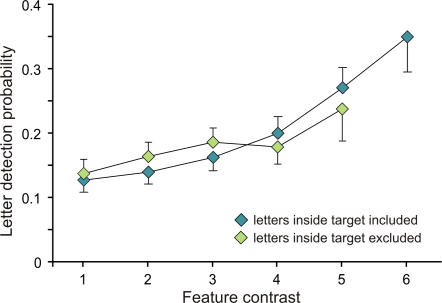
Effect of local orientation contrast on letter detection probability.The letter detection rate increased proportionally with the orientation contrast. Contrast level is represented on the X-axis and percentage of detection on the Y-axis. Error bars correspond to standard errors.